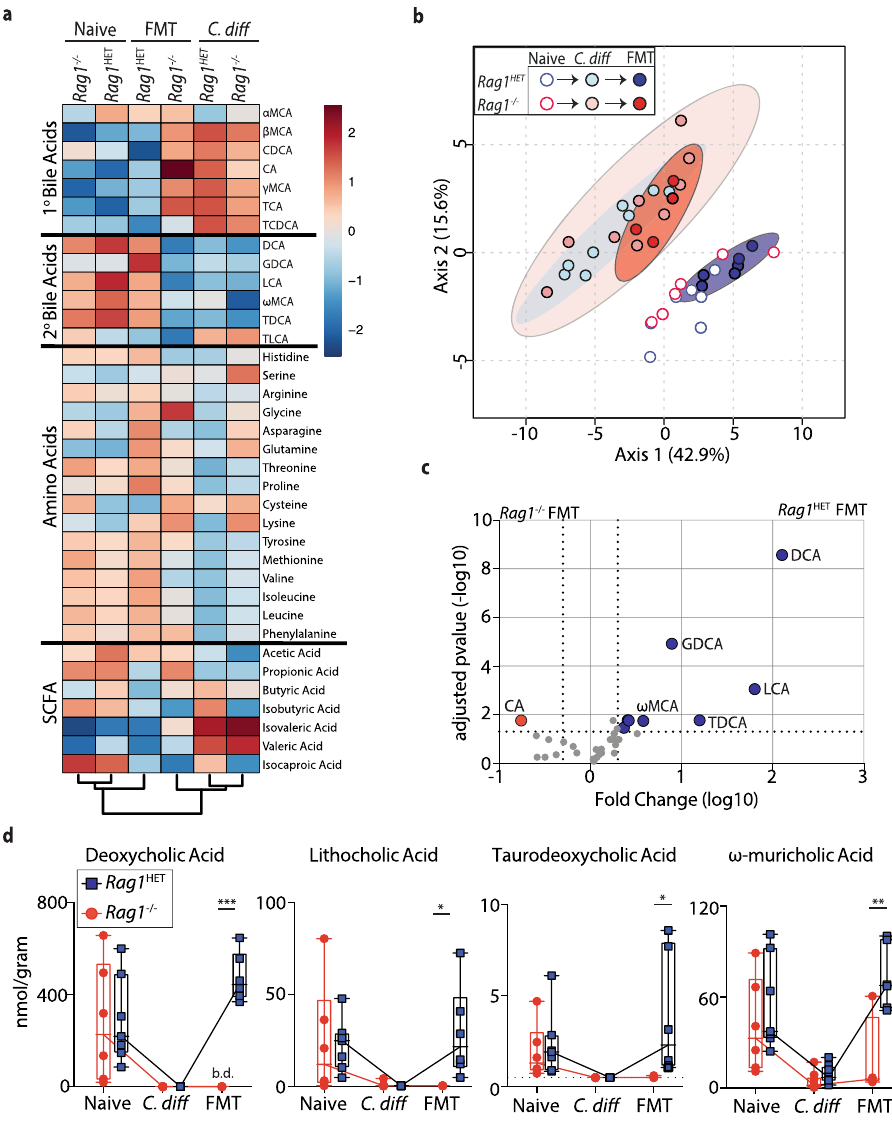
Fig. 6 FMT non-responsive Rag1 − / − mice fail to restore their intestinal metabolite pro fi le to pre-infection conditions. C. dif fi cile -infected Rag1 − / − and Rag1 HET mice were administered FMT or PBS, sacri fi ced 21 days later along with naïve mice and amino acid, short chain fatty acid (SCFA), 1° and 2° bile acid pools were analyzed in cecal content. a Heatmap of relative concentration of amino acids, SCFA, 1° and 2° bile acids in cecal content of naïve ( n = 5), C. dif fi cile -infected ( n = 6) or C. dif fi cile -infected FMT-treated ( n = 4 Rag1 − / − ; n = 6 Rag1 HET mice). b Principal coordinate analysis plot comparing con fi dence intervals. c Volcano plot of metabolites in the cecum of C. dif fi cile -infected FMT-treated Rag1 − / − and Rag1 HET mice. Blue circles indicate metabolites enriched in Rag1 HET mice. Red circles indicate metabolites enriched in Rag1 − / − mice. Signi fi cance threshold criteria set at a two-fold change in concentration and an adjusted p -value of 0.05 using an unpaired t -test and adjusted for false discovery rate. d Concentration of individual 2° bile acids. n = 5 naïve Rag1 − / − and Rag1 HET mice; n = 6 C. dif fi cile -infected Rag1 − / − and Rag1 HET mice; n = 4 C. dif fi cile -infected FMT-treated Rag1 − / − ; n = 6 C. dif fi cile